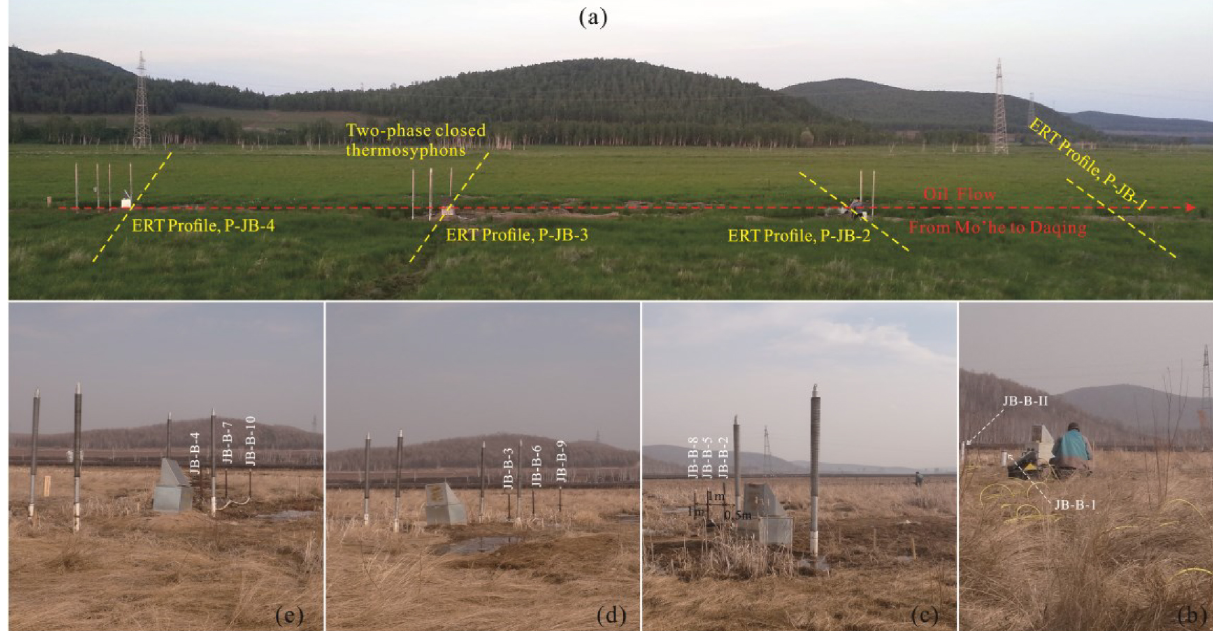
Figure C3. Picture of the monitored cross sections, perpendicular to the pipeline at 20m intervals, at the JB permafrost site. Notes: (a) Plane view, (b) Section 1, without thermosyphon, (c) Section 2, one pair of thermosyphons, (d) Section 3, two pairs of thermosyphons at a longitudinal spacing of 1.3m, and (e) Section 4, two pairs of thermosyphons at a longitudinal spacing of 1.4m. The data acquisition device is the same as that at the JS site.